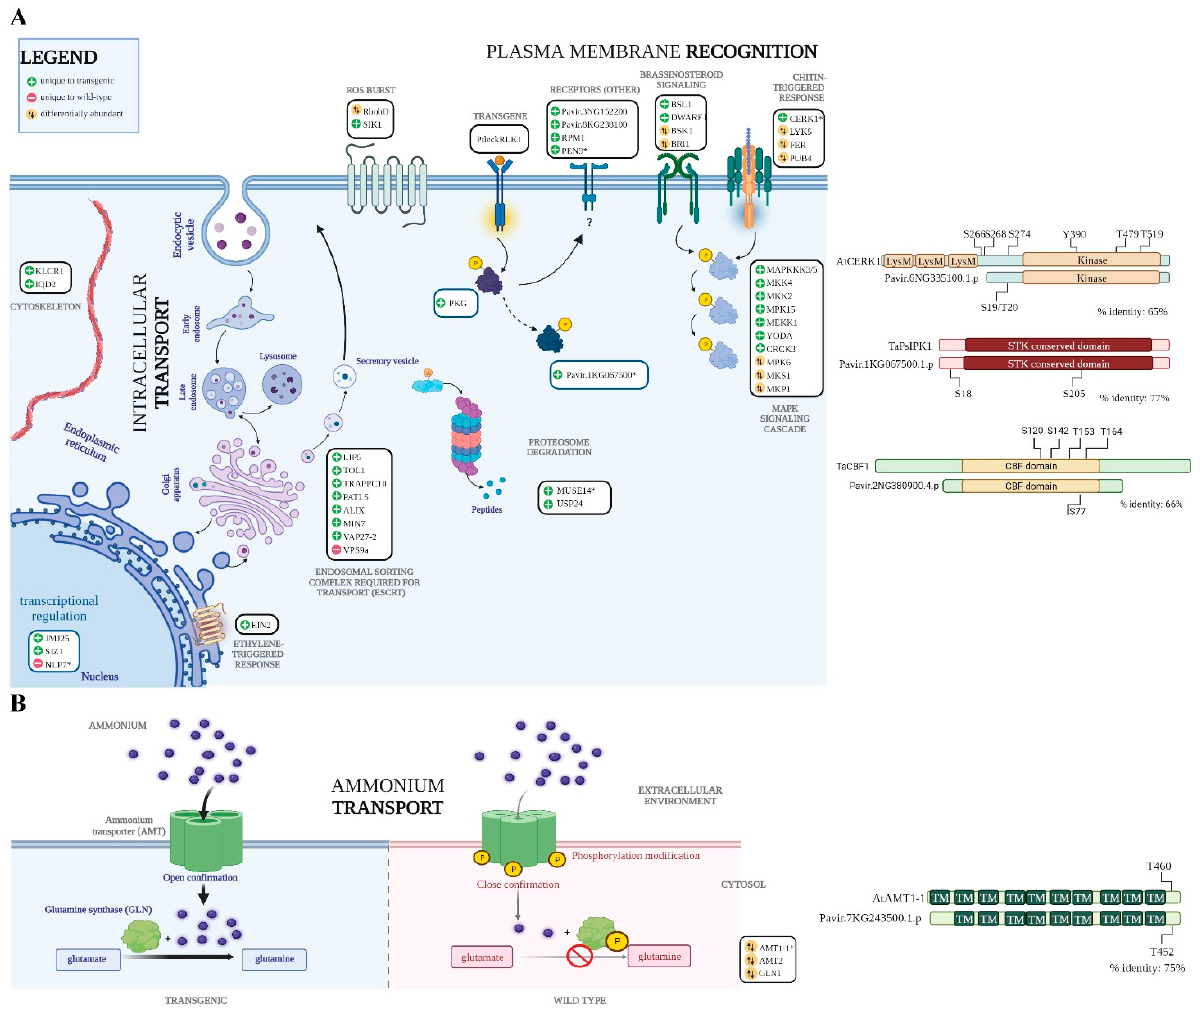
Figure 2. Signaling cascade and post-invasion molecular signature regulated as a result of PtLe- cRLK1 engineering in non-host plant. ( A ) Various signaling cascade mapped by significantly changed phosphopeptides in L. bicolor -inoculated transgenic line compared to WT. ‘+’ represent the phosphorylation unique to transgene, ‘ − ’ represent the phosphorylation unique to wild type, and ‘ ↑↓ ’ represent the phosphorylations that are identified in both transgene and WT but are differentially abundant. Some of the key proteins involved in plant–fungal interaction are shown with ‘*’ in accession and their simplified sequence alignments are shown on the right (see Supplemental Table S3 for gene alias information). ( B ) Simplified model showing the regulation of ammonia uptake through ammonium transporter via phosphorylation modification. The phosphorylation of conserved threonine level negatively correlates with root ammonium uptake. Simplified sequence alignment for AMT1-1 is shown on the right with conserved threonine site.